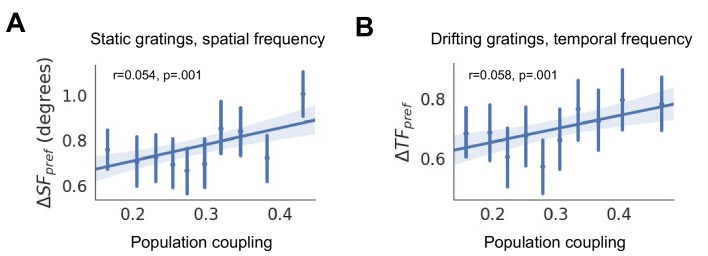
Changes in spatial frequency selectivity (Δ⁢SFpref, (A)) and temporal frequency selectivity (Δ⁢TFpref, (B)) are correlated with population coupling.